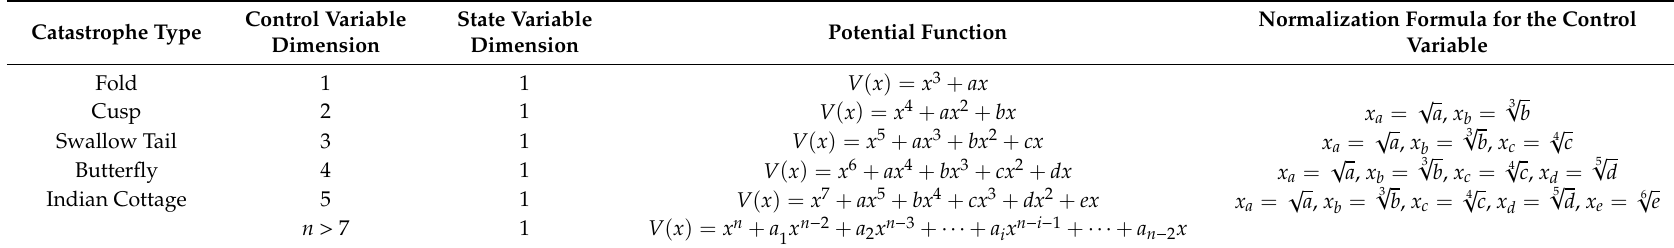
Table 2. Expanded cusp catastrophic